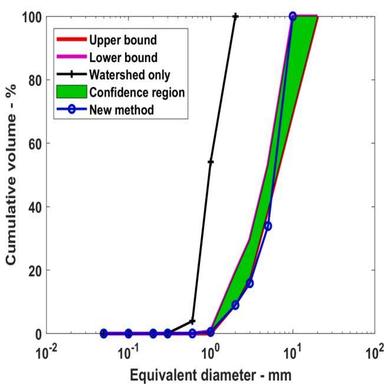
A comparison between the particle size distribution curves obtained from particles after watershed only as shown in 5 (b) and particles after the new method as shown in 5 (c); the green confidence region is based on 5 measurements using the CAMSIZER. (For interpretation of the references to color in this figure legend, the reader is referred to the web version of this article.)